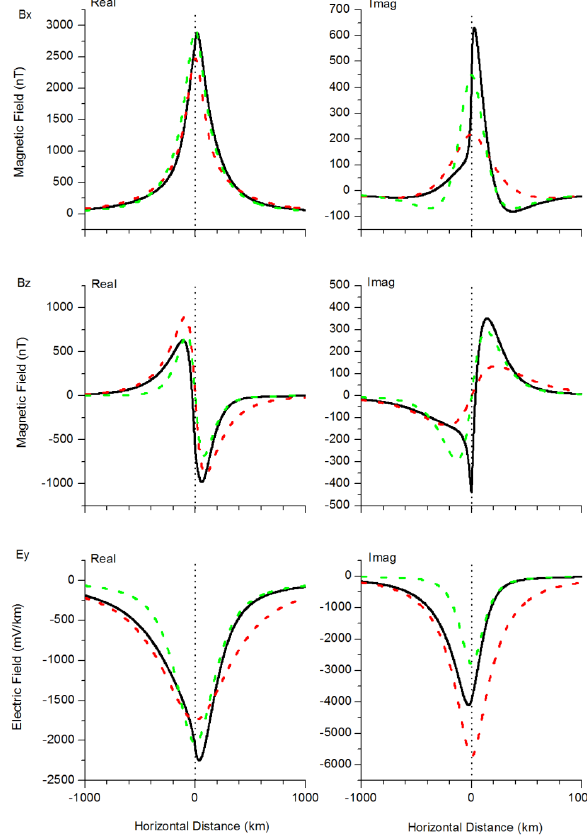
Fig. 9. The electric and magnetic field components at the Earth’s Figure 9. The electric and magnetic field components at the Earth’s surface are shown for 2 surface are shown for three different cases. The red curves rep- resent the results with the Quebec layered earth model, the green three different cases. The red curves represent the results with the Quebec layered earth 3 curves represent the results with the BC layered earth model and model, the green curves represent the results with the BC layered earth model and the black 4 the black curves represent the results with the combination of the curves represent the results with the combination of the layered earth structure of Quebec for 5 layered earth structure of Quebec for x <0 and the layered earth structure of BC for x >0 (see Fig. 8). The line current is located x < 0 and the layered earth structure of BC for x > 0 (see Fig. 8). The line current is located 6 100km above the x =0 point, which is the interface between the 100 km above the x = 0 point which is the interface between the Quebec structure and the BC 7 Quebec structure and the BC structure. The computations are based structure. The computations are based on FEM with a period of 300 s. 8 on FEM with a period of